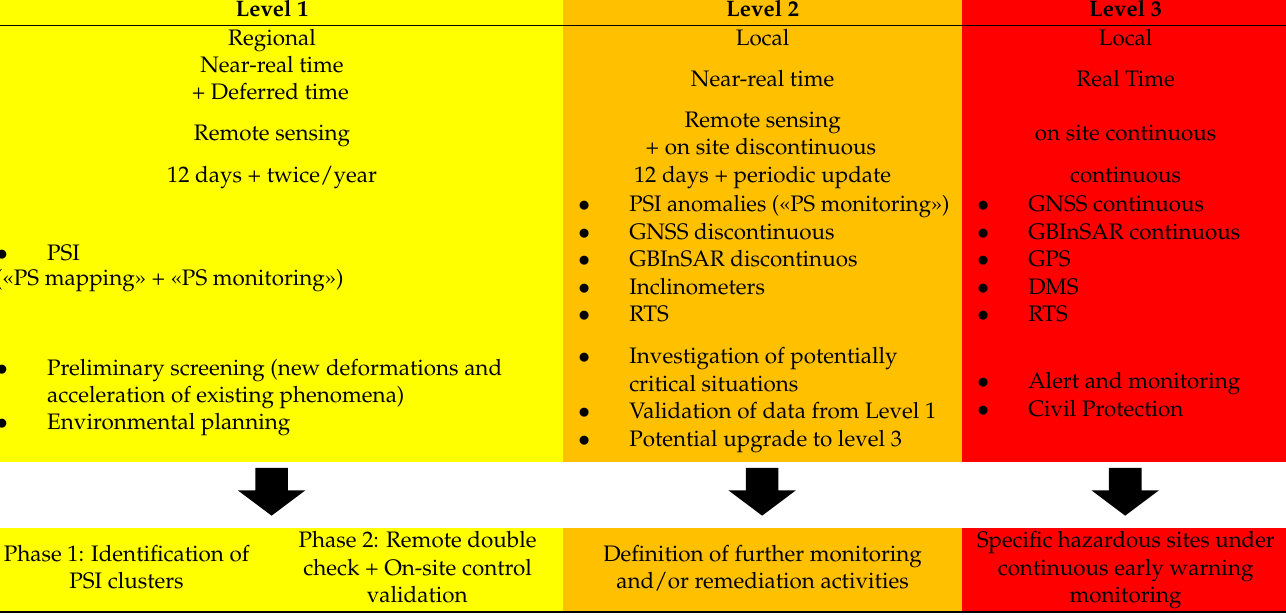
Table 1. Scheme of the three monitoring levels and related actions in the monitoring network in the Valle D’Aosta regional Civil Protection (VARCP).